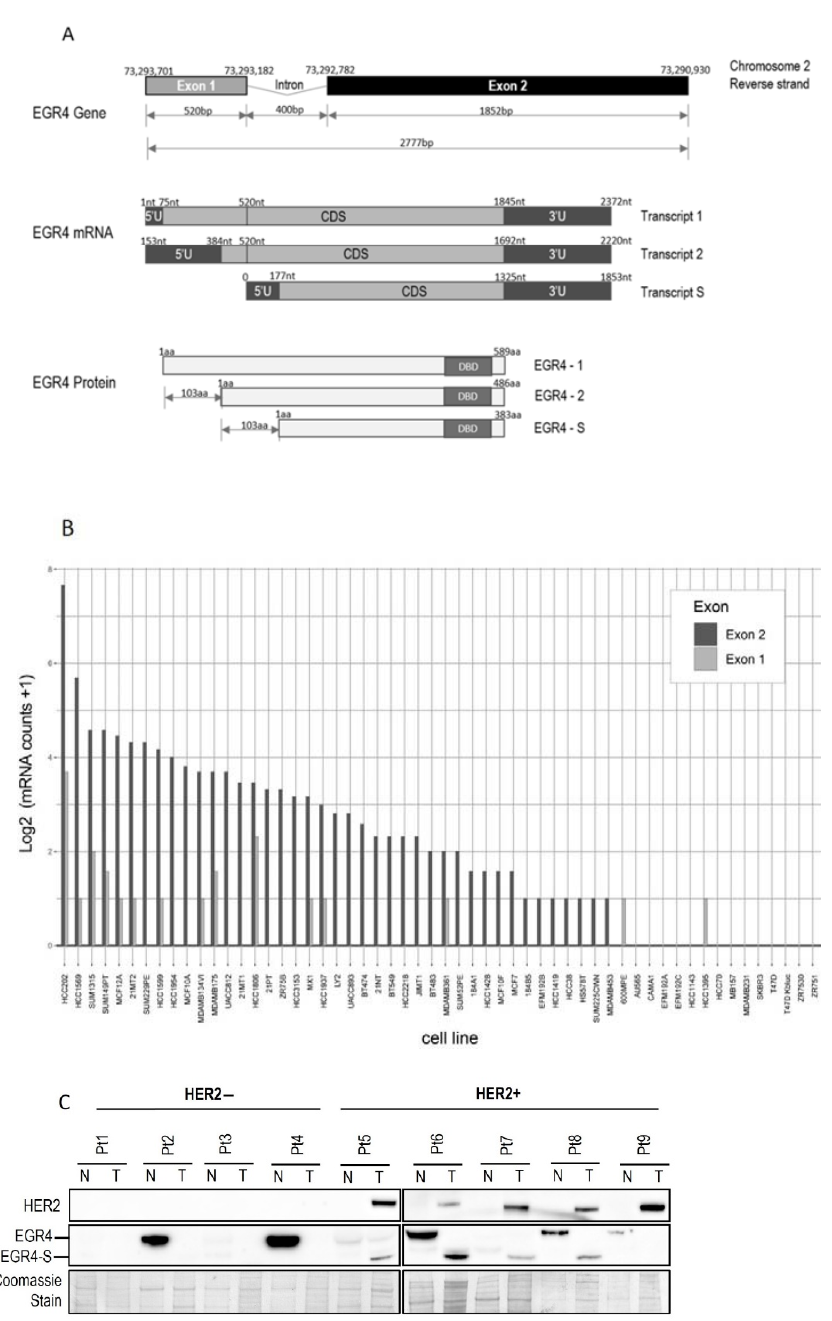
Figure 2. Structure of the EGR4 gene and splice variant expression in cells and tumour tissue. ( A ) Schematic diagram of the Human EGR4 gene, located on Chromosome 2, showing its 2 exon structure ( top ), the 3 possible mRNA transcripts ( middle ), and 3 hypothetical protein isoforms arising from these different transcripts ( bottom ). Based on: https://www.ensembl.info/known- bugs/ensembl-100/ (accessed on 15 August 2017). ( B ) RNAseq analysis for EGR4 exon expression in 56 different breast cancer cell lines. Reads were normalised to exon size by scaling to base-level coverage. ( C ) Example of Western blot results for HER2 and EGR4 expression in normal (N) and breast tumour (T) biopsies from HER2 − (pt 1–4) and HER2+ (pt 5–9)